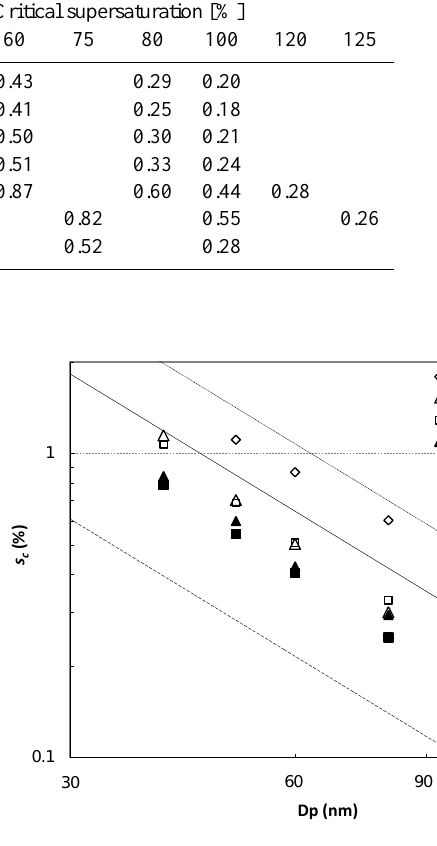
Fig. 6. Measured critical supersaturations for the K-puszta samples. The lines represent the supersaturation ratios of three different ar- bitrary ideal compounds as a function of dry diameter, D p , and are intended solely to guide the eye on the ideal dependence of s c on D p . These s c values are calculated according to Eq.